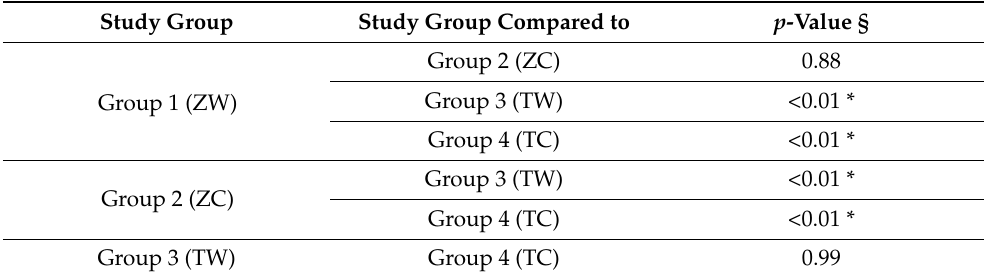
Table 4. Individual group (Inter-group) comparison of post treatment micro-hardness among study groups. Study Group Study Group Compared to p -Value § Group 2 (ZC) 0.88 Group 3 (TW) <0.01 * Group 1 (ZW) Group 4 (TC) <0.01 * Group 3 (TW) <0.01 * Group 2 (ZC) Group 4 (TC) <0.01 * Group 3 (TW) Group 4 (TC) 0.99